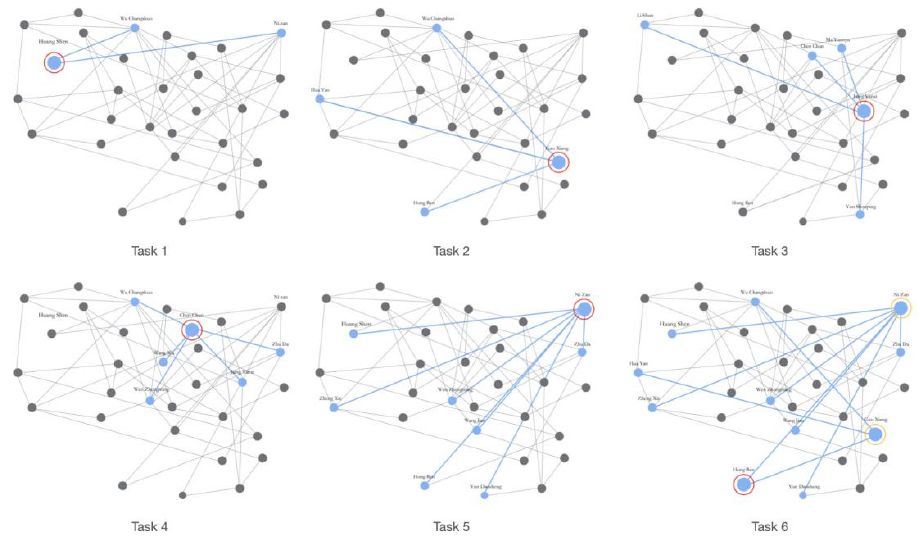
Figure 4. Examples of task 1 to task 6.